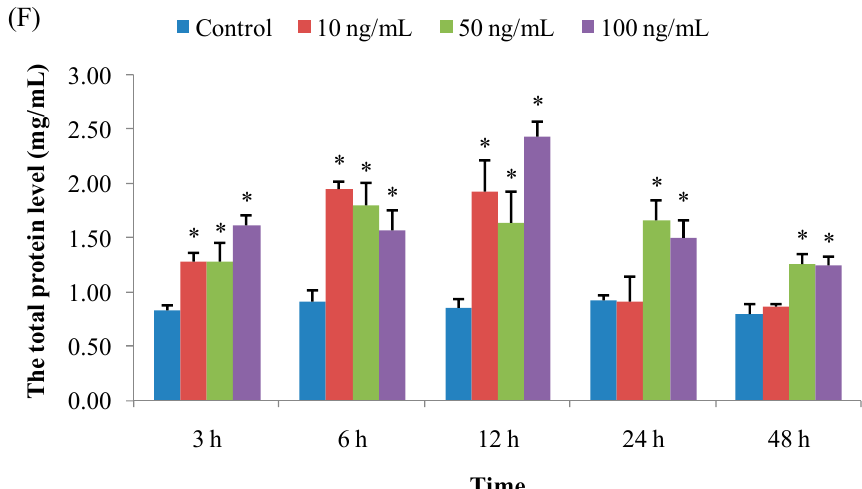
Figure 1. E ff ects of domoic acid (DA) on non-specific immune responses of the bay scallop Argopecten irradians at di ff erent time intervals after exposure to DA at three concentrations (10, 50, and 100 ng / mL). Figure 1. Effects of domoic acid (DA) on non-specific immune responses of the bay scallop ( A ) acid phosphatase (ACP); ( B ) alkaline phosphatase (ALP); ( C ) lactate dehydrogenase (LDH); ( D ) Argopecten irradians at different time intervals after exposure to DA at three concentrations (10, 50, lipid peroxide (LPO); ( E ) nitric oxide (NO) level; ( F ) total protein concentration. Data represent mean ± and 100 ng/mL). ( A ) acid phosphatase (ACP); ( B ) alkaline phosphatase (ALP); ( C ) lactate SD values ( n = 3) during sampling with “*” denoting significant di ff erences between the treatments of dehydrogenase (LDH); ( D ) lipid peroxide (LPO); ( E ) nitric oxide (NO) level; ( F ) total protein each exposure time ( p < concentration. Data represent mean ± SD values ( n = 3) during sampling with “*” denoting significant differences between the treatments of each exposure time ( p < 0 .05 ).